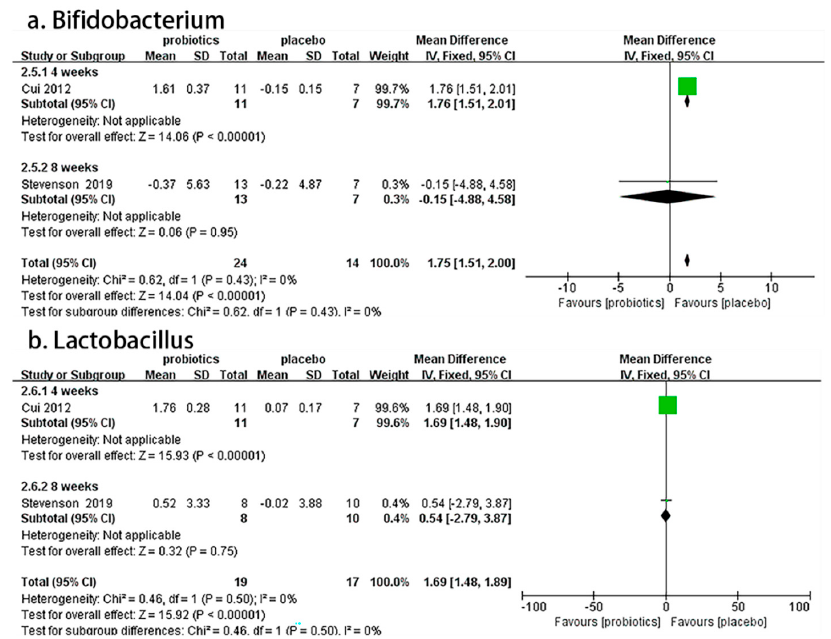
Figure 4. Effect of probiotics on changes in fecal counts of Bifidobacterium and Lactobacillus in IBS-C patients. The green block represents the effect sizes of individual studies, black diamond block represents the combined effect size.